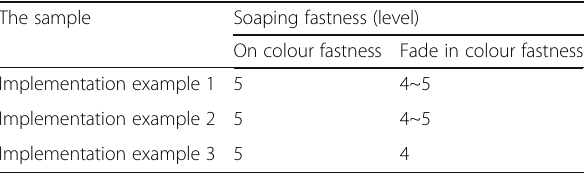
Table 1 Tests were conducted on the soaping fastness of cashmere